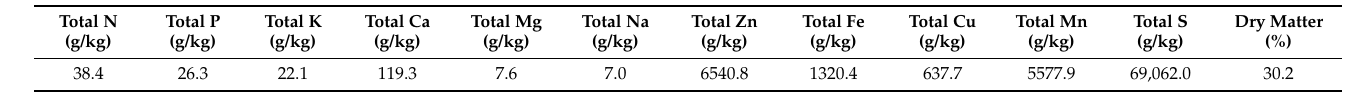
Table 2. Estimated mineral composition of the poultry manure used in the study. Total N